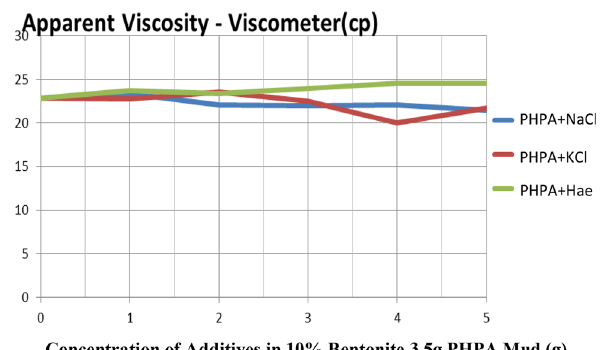
Fig. 13 Effect of haematite on plastic viscosity of CMC–bentonite mud in accordance with time